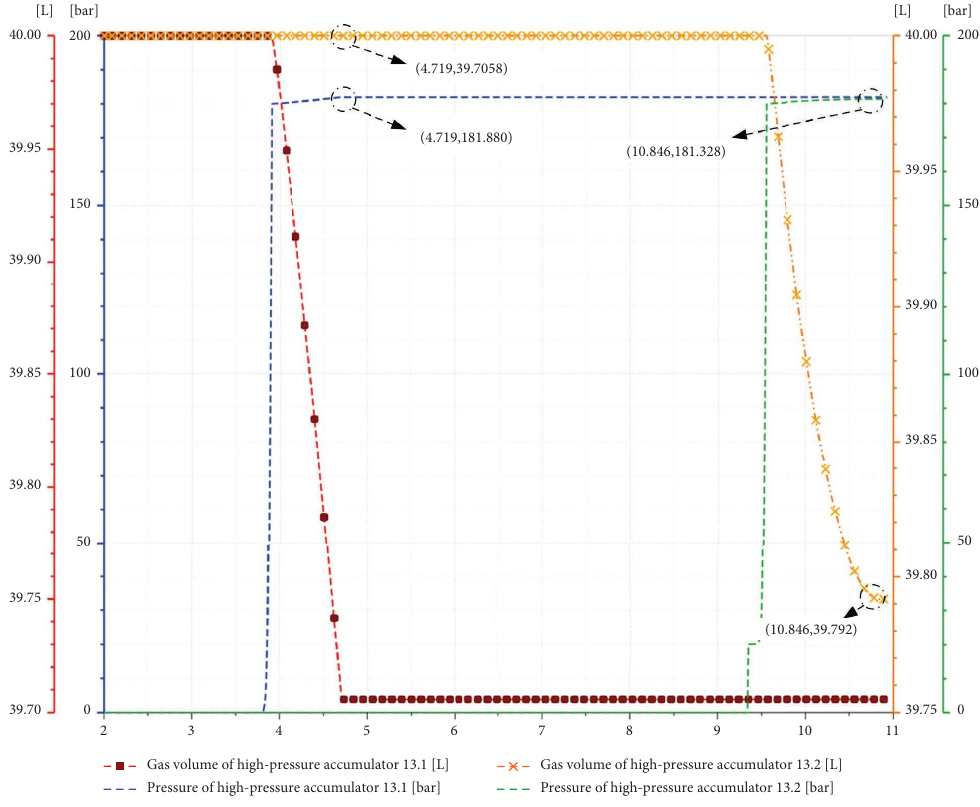
Figure 13: Pressure and volume changes in high-pressure accumulators during bite-in and